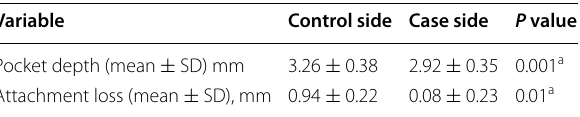
Table 4 Periodontal status of the two sides 6 months after the surgery